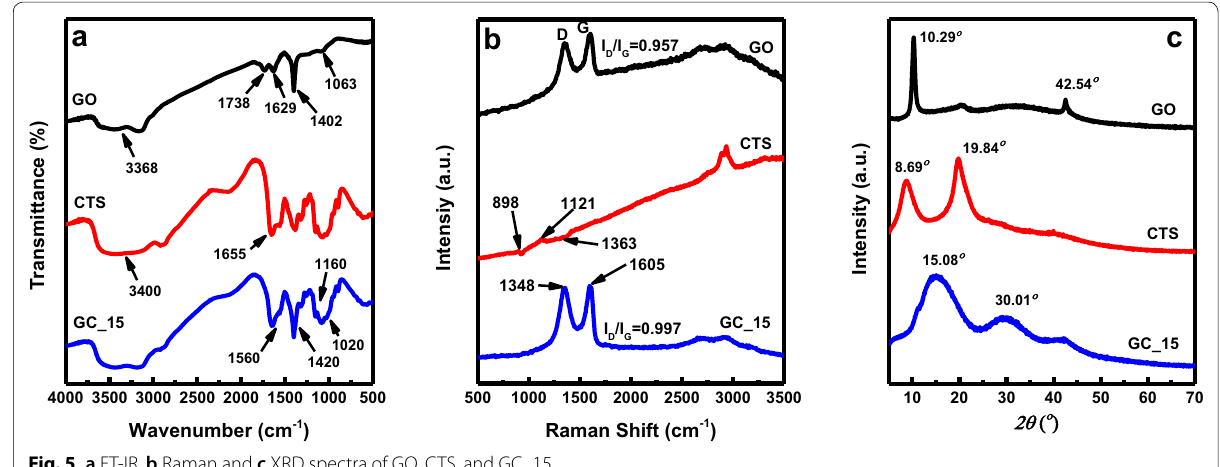
Fig. 5 a FT-IR, b Raman and c XRD spectra of GO, CTS, and GC_15